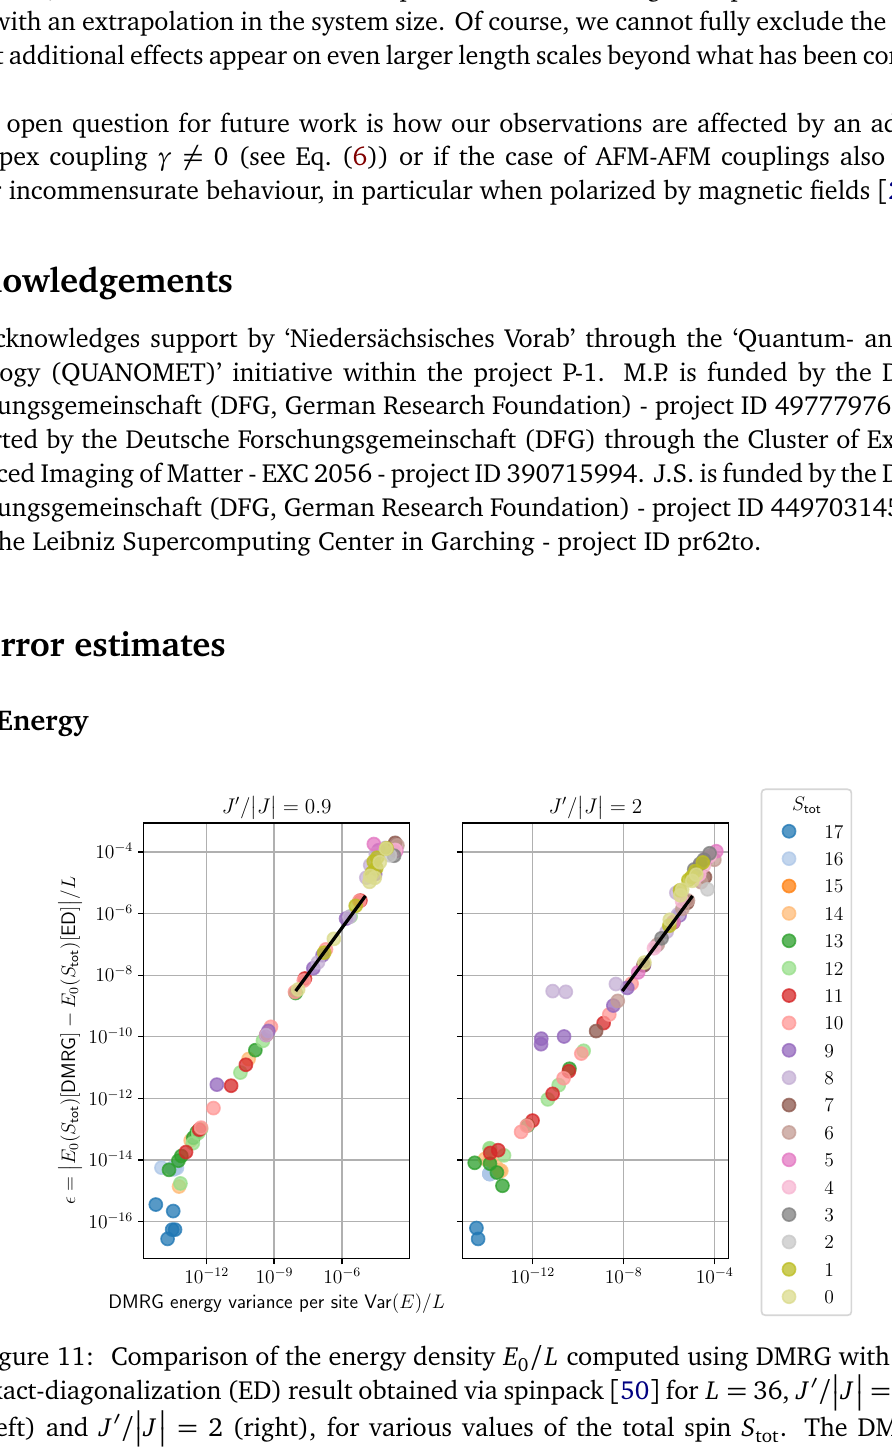
Figure 11: Comparison of the energy density E exact-diagonalization (ED) result obtained via spinpack [ 50 ] for L = 36, J ′ / (cid:12) (cid:12) (left) and J ′ / (cid:12) J (cid:12) = 2 (right), for various values of the total spin S tot . The DMRG results are computed for different bond dimensions χ different energy variances per site (see Eq. (7)). The black line is a linear fit, see (cid:12) (cid:12) Eq. (A.14). For J ′ / (cid:12) J (cid:12) = 2 and S tot = 8,9 we were only able to achieve an agreement within ε ∼ 10 − 10 − 10 − 9